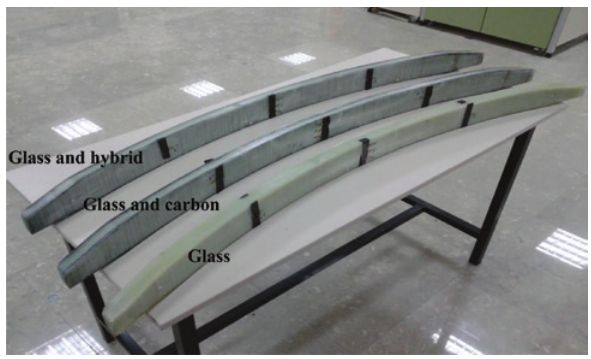
Figure 13: Photographs of the manufactured